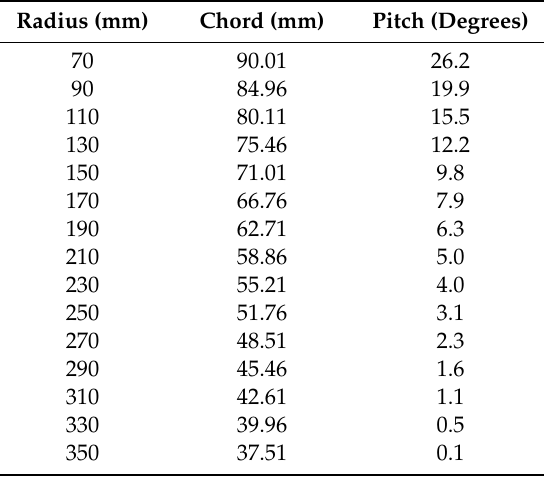
Table 1. Parameters of the